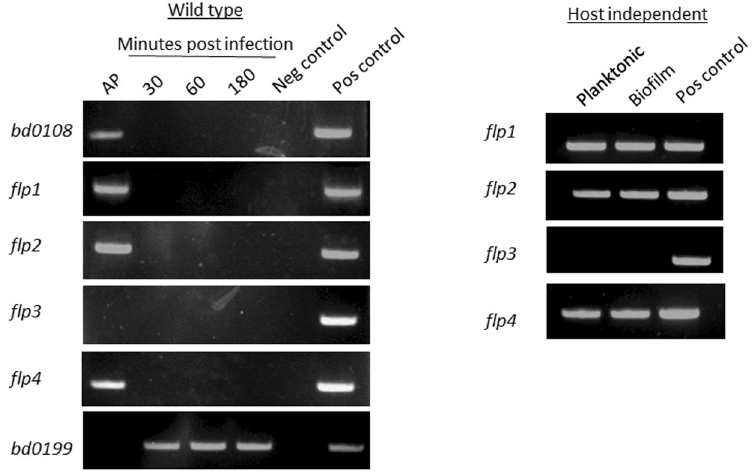
Figure 4. Semi-quantitative RT-PCR (sqRT-PCR) of B. bacteriovorus flp pilin genes. Expression of flp pilin encoding genes during the B. bacteriovorus HD100 life cycle shows that flp1, flp2 and flp4 are expressed during AP, while flp3 is silenced during the whole cycle. The same expression pattern was observed in a host- independent biofilm and in a planktonic culture, with flp1 and flp2 are expressed and flp 3 is silent. bd0108 is used as a AP marker and bd0199 as a GP marker. A) Negative control - E. coli DNA. B) positive control - B. bacteriovorus DNA. Gels were acquired with DNR Gel Capture with no further processing.